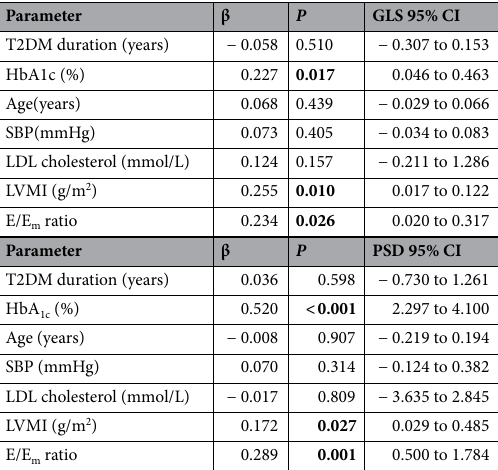
Table 4. Risk factors for GLS and PSD values in the LV in T2DM patients. Β standardization coefficient beta, CI confidence interval, T2DM type 2 diabetes mellitus, HbA 1c hemoglobin A 1c , SBP systolic blood